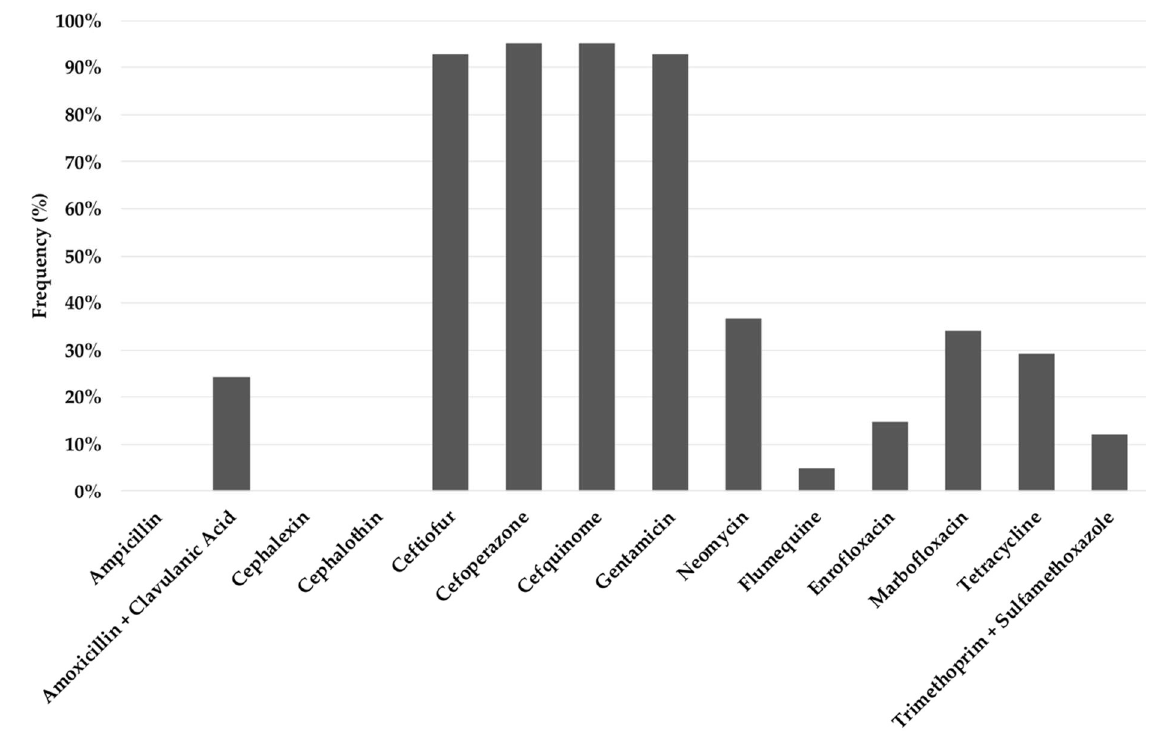
Figure 2. Percentage of enterotoxigenic Escherichia coli isolates susceptible to each antimicrobial tested.